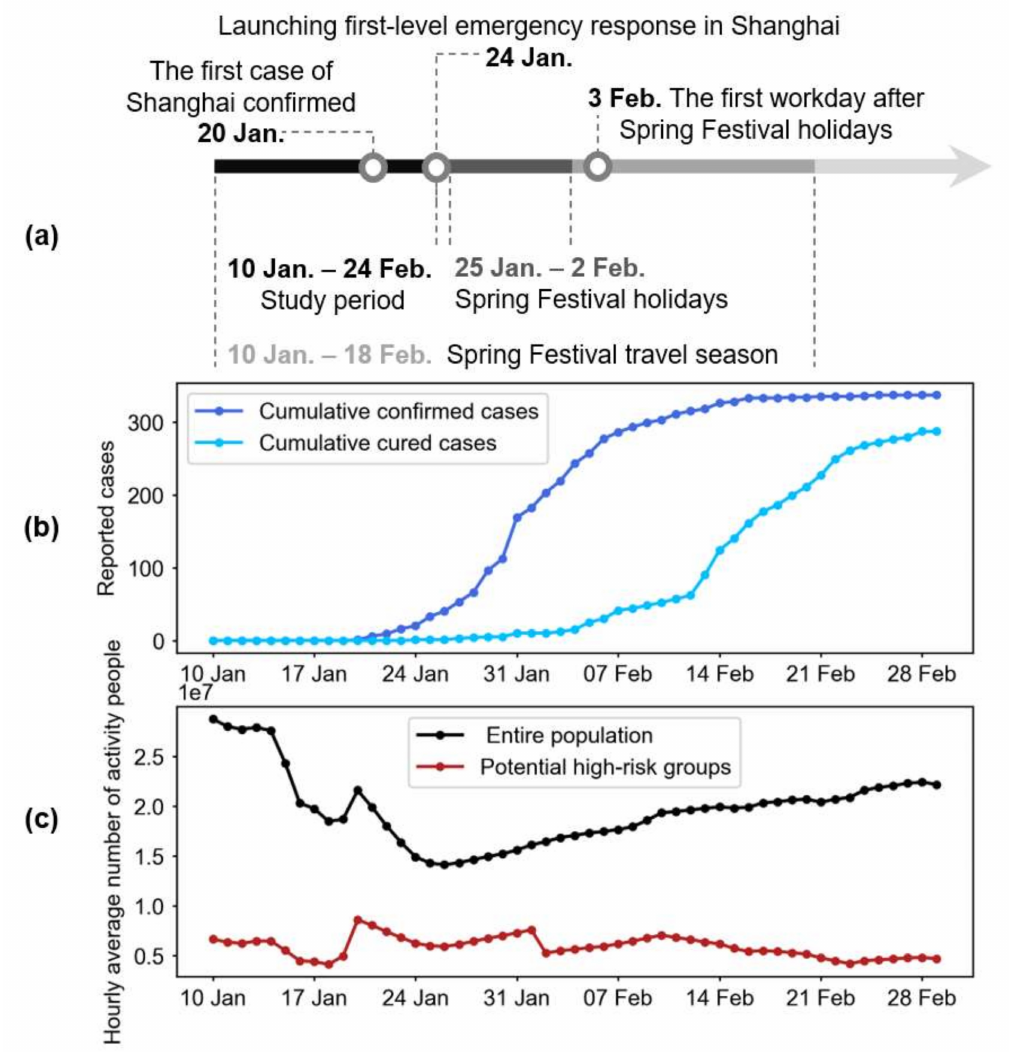
Figure 5. Timeline ( a ), trends in COVID-19 cases ( b ) and changes in the population ( c ) of the